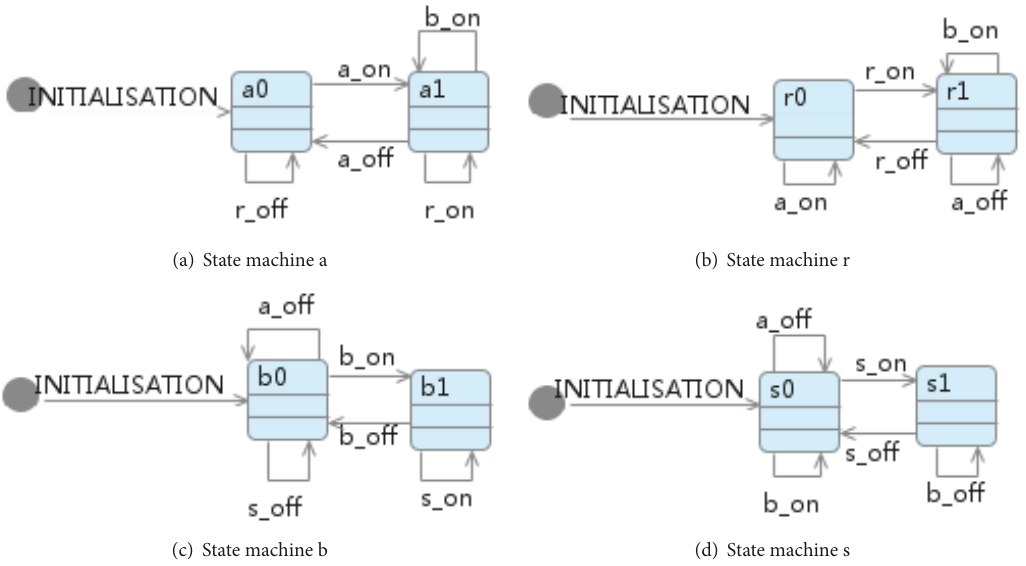
Figure 12: The iUML-B state machines of strong-weak synchronization